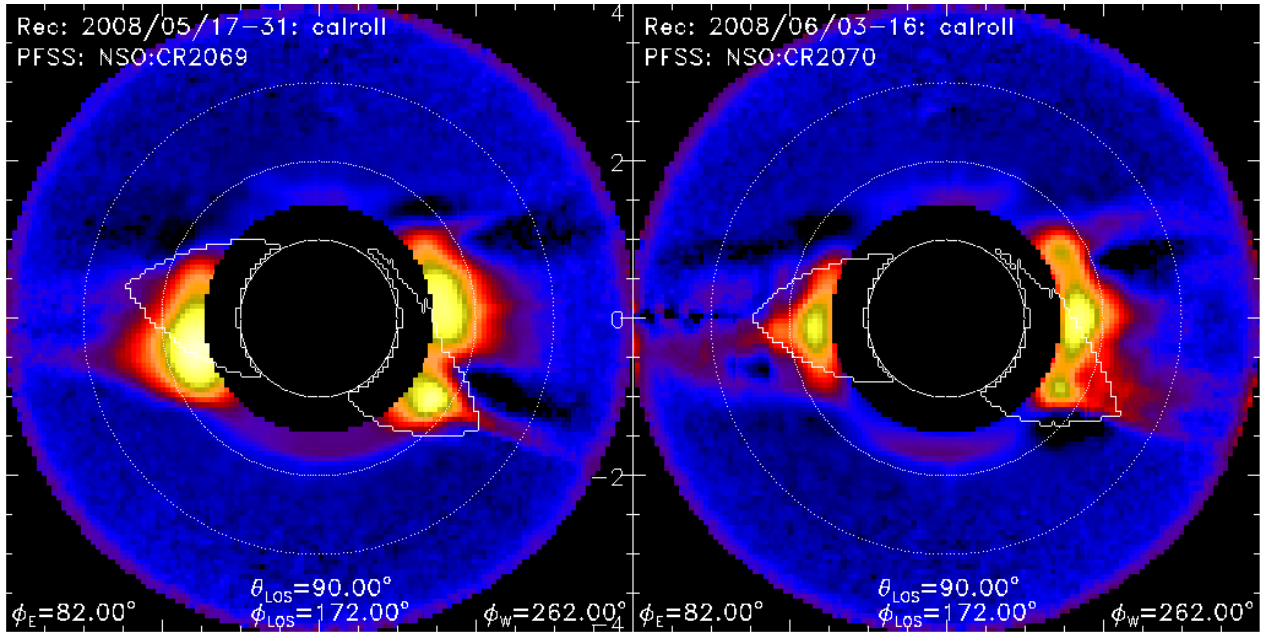
Fig. 2. Cross-sections of the reconstructed electron density in square root scale by a plane perpendicular to a LOS with Carrington longitude of 172 ◦ and colatidude of 90 ◦ . The reconstruction for the period before a CME of 1 June 2008 is shown on the left side while the reconstruc- tion for the period after this CME is shown on the right side. The white contour lines are the boundaries between closed and open magnetic field lines for a PFSS model with source surface at 2.5 R (cid:12) for CR 2069 and CR 2070, i.e. periods approximately before and after the CME. The white circles mark heliospheric distances for 1, 2 and 3 R (cid:12) .